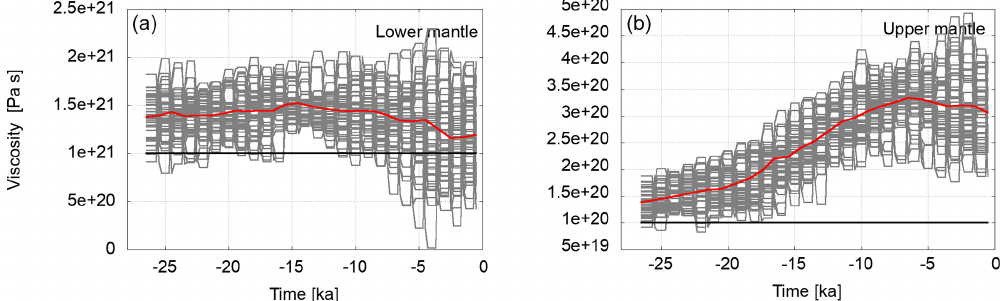
Figure 20. Development of ensemble with erroneous ice load. The ice load was increased globally by 5%. Red lines denotes the ensemble means and black lines the target values.